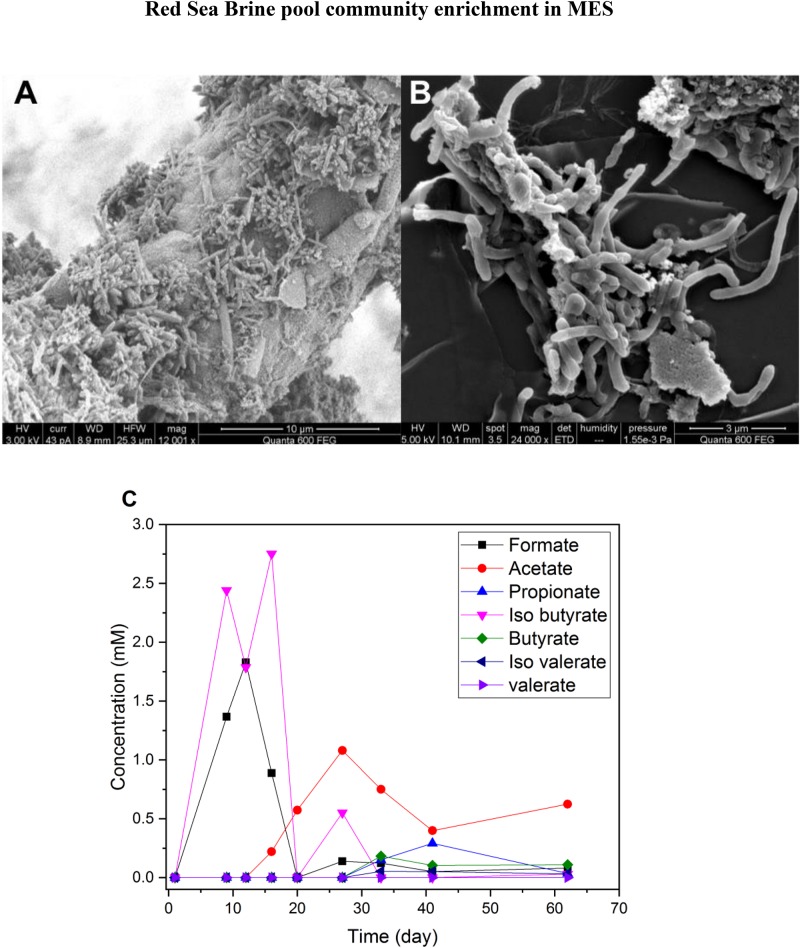
(A) SEM image of old biofilm (150 days) on the cathode surface from MES reactor R1 (phase I). (B) SEM image of biomass pellet obtained from H2:CO2 serum vial (phase I) after 60 days of incubation in synthetic saline media (10% salinity). (C) VFA production in H2:CO2 serum vial (phase I) with synthetic saline media (10% salinity).